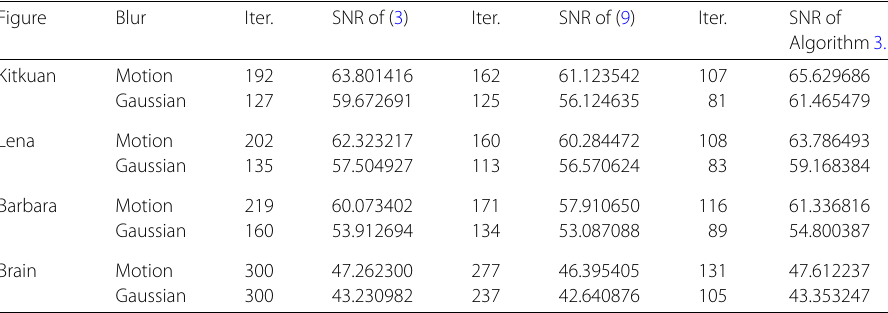
Table 1 SNR values of the restored images in Figs. 1 and 2